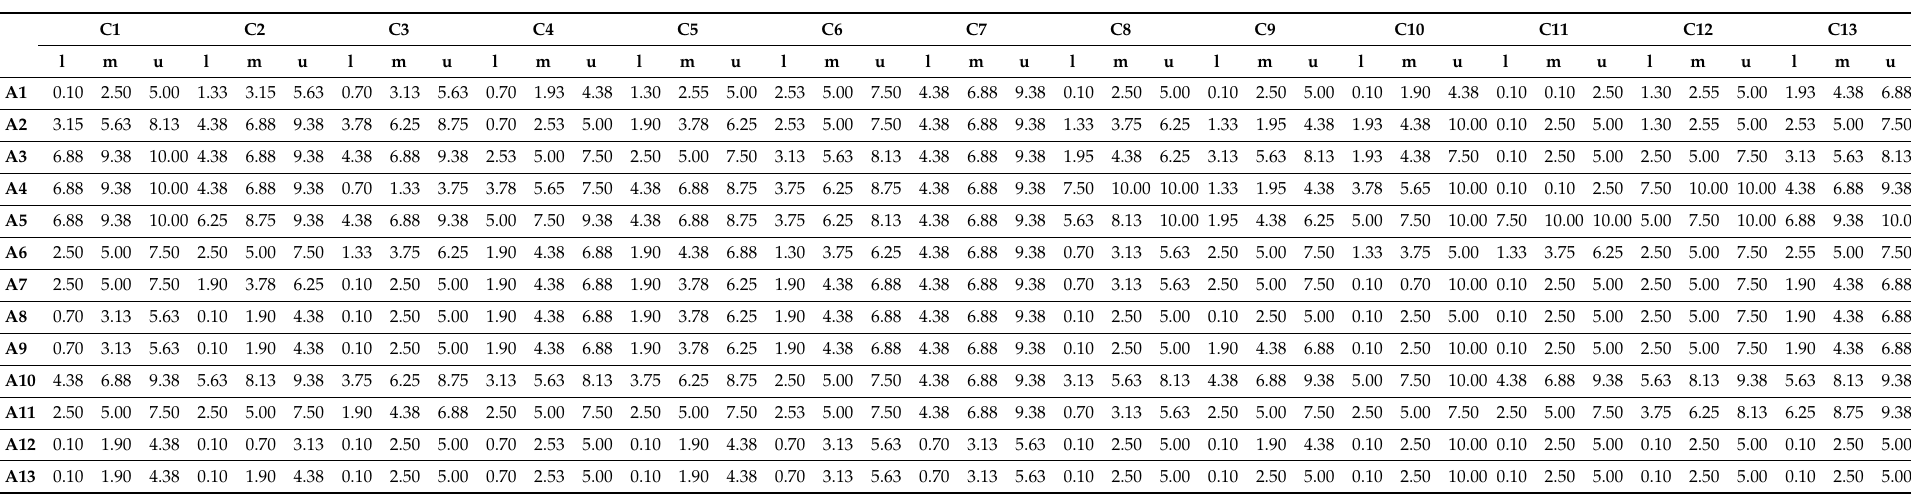
Table 5. Decision matrix with the aggregated